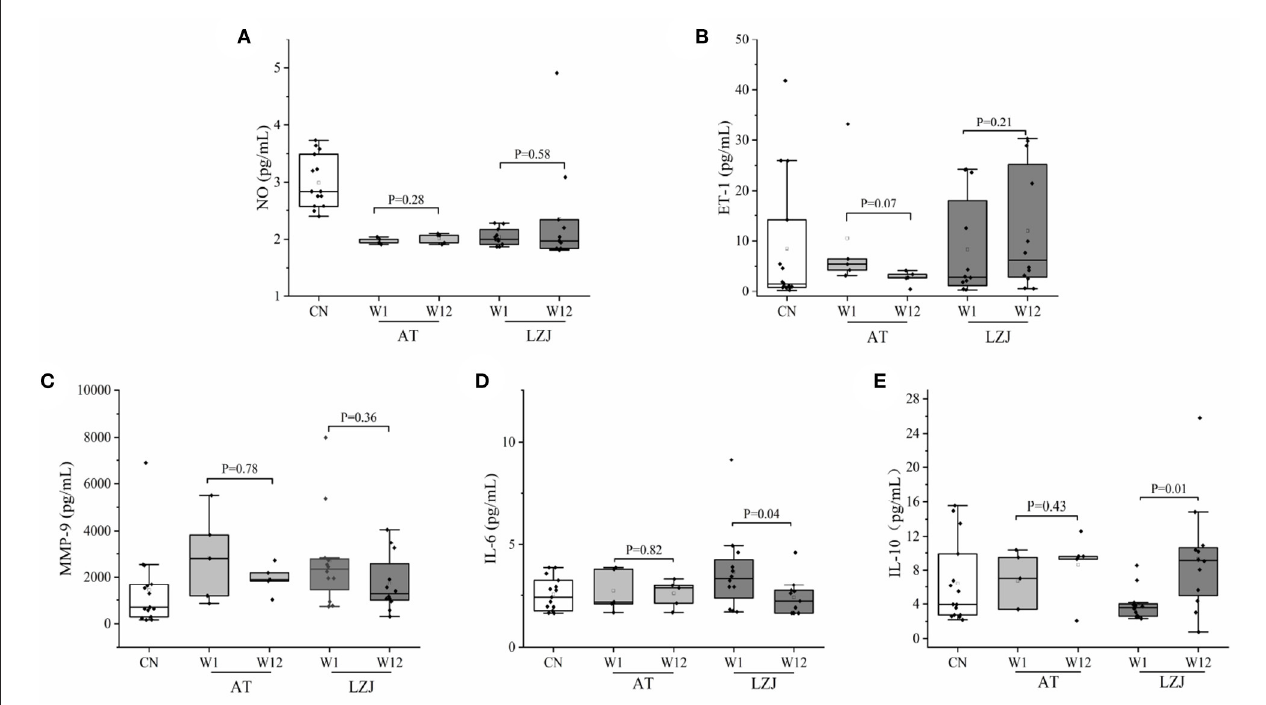
FIGURE4 BP responder specific changes in the vascular endothelial function and immune response. (A–E) LZJ and AT caused changes in ET-1, NO, MMP-9, IL-6, and IL-10 in hypertensive patients persisting 3 months later. The line within the boxplot indicates the median. Whiskers are drawn to minimum and maximum values, but not further than 1.5 × IQ. Differences in exercise intervention for 12-week changes from baseline of laboratory indexes were tested by analysis of t -test or Mann-Whitney- U test based on whether the data were normally distributed.